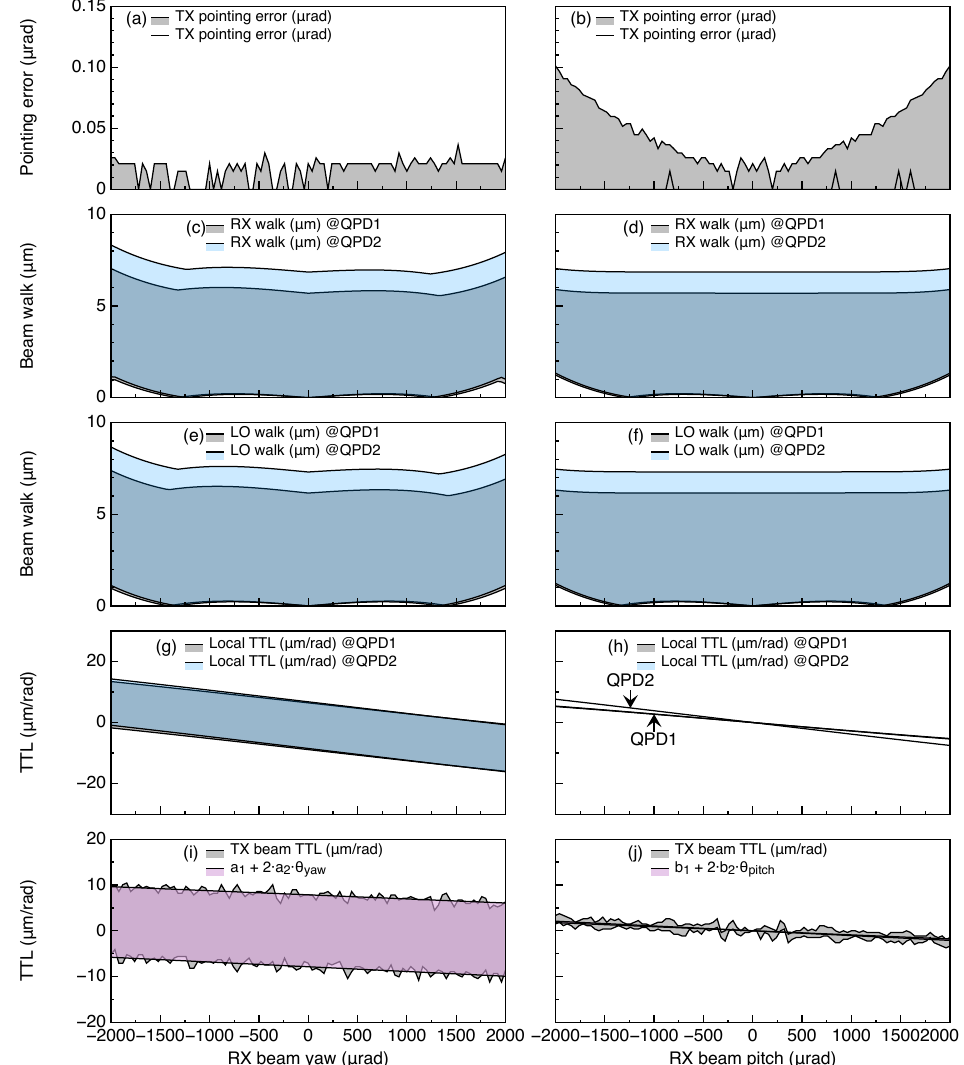
Figure 8. Thermal analysis. The temperature is swept in the ± 3K range in seven steps, and the TTL coupling simulation is carried out for each step of temperature and RX beam tilt in the pitch and yaw degrees of freedom. The shaded regions shown in the plots are bounded by the maximum and minimum results for TX pointing error ( a , b ), RX beam walk ( c , d ), LO beam walk ( e , f ), local TTL coupling ( g , h ), and TX beam TTL coupling ( i , j ) throughout the temperature